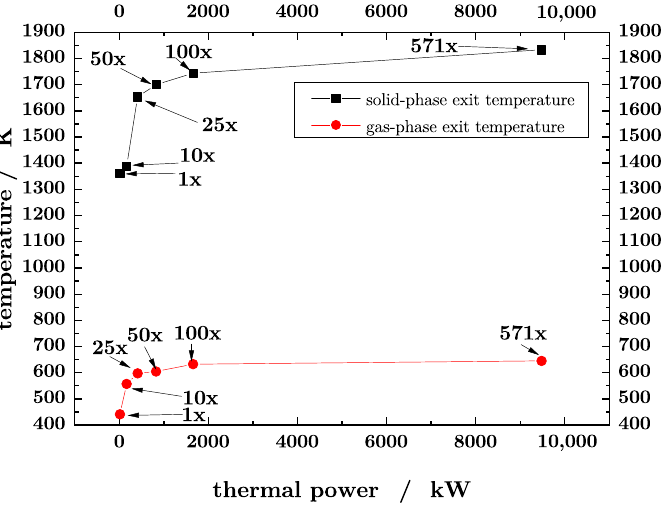
Figure 9. The influence of the gasifier size (thermal input) on both gas-phase and solid-phase exit temperatures for constant residence time scaling [20] .